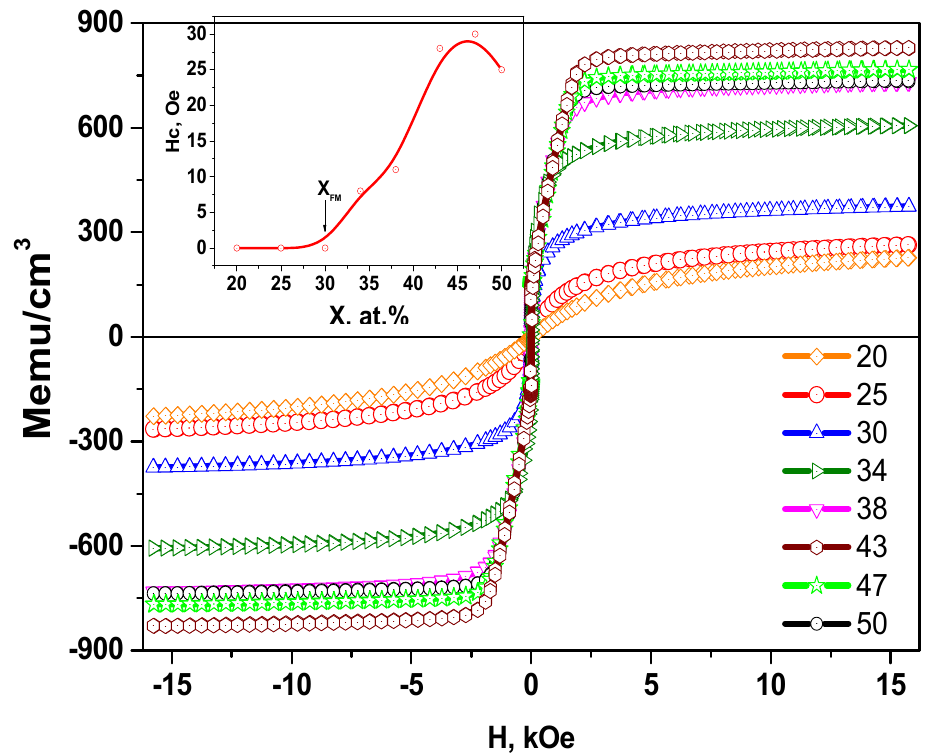
Nanomaterials 2021 , 11 , x FOR PEER REVIEW 10 of 17